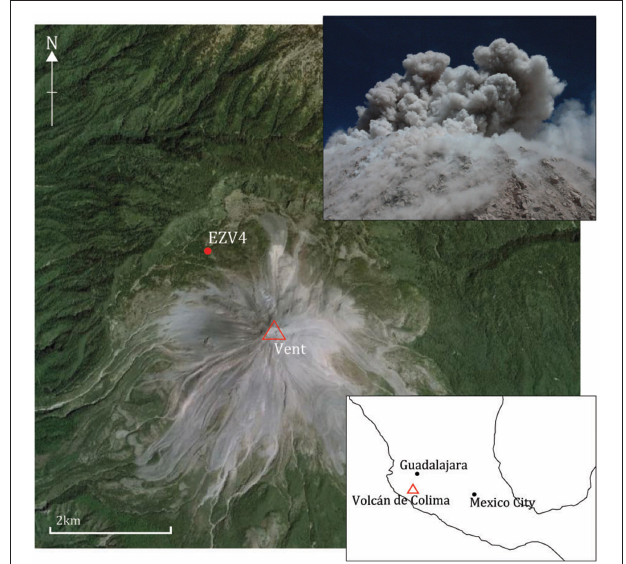
FIGURE 2 | Aerial view of Volcán de Colima with seismic station EZV4 location relative to the active vent at the lava dome. Insert 1: A small gas-and-ash explosion on 18 April 2009 at Volcán de Colima. Gas can be seen emerging from much of the dome surface. Insert 2: Map showing Volcán de Colima location in Mexico [Main image from Google Earth Pro V7.1.2.2041 (28/02/2015). Location: Volcán de Colima, Tonila, Mexico 19 ◦ 30 ′ 50.40 ′′ N 103 ◦ 37 ′ 12.00 ′′ W, Eye alt. 47,500 feet. DigitalGlobe 2016. http://earth.google. com (accessed October 14